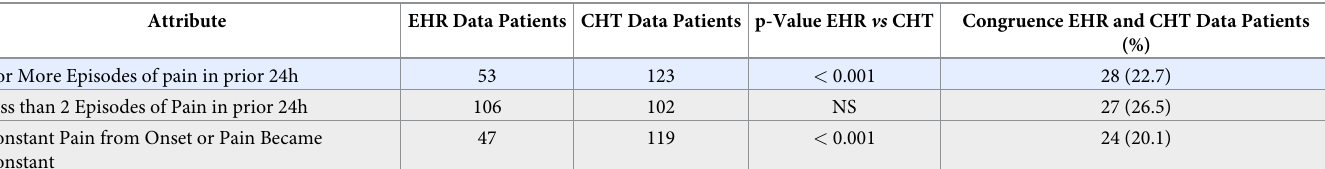
Table 5. Frequency and duration of pain.